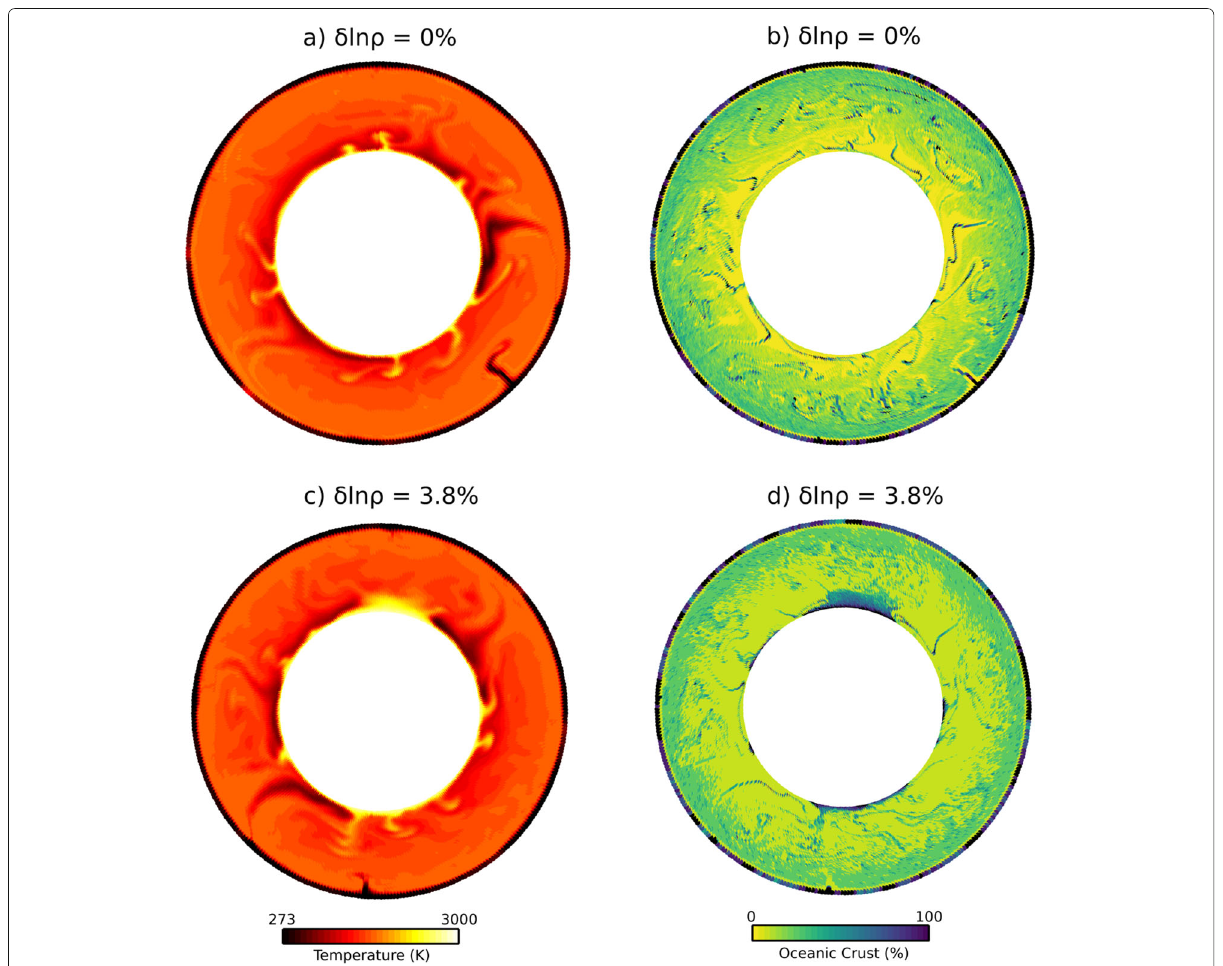
Fig. 2 Plot of temperature and composition fields for Brandenburg et al. (2008) models for δ ln ρ of 0% ( a , b ) and 3.8% ( c , d ), where we use the non-linear radial projection of the models onto Earth coordinates. In both cases, recently subducted oceanic crust meets the CMB and the low viscosity upper mantle has been homogenized by convective stirring relative to the lower mantle. When δ ln ρ = 0%, oceanic crust is somewhat evenly distributed throughout the lower mantle. In contrast, when δ ln ρ = 3.8%, oceanic crust accumulates and the CMB forms sharp